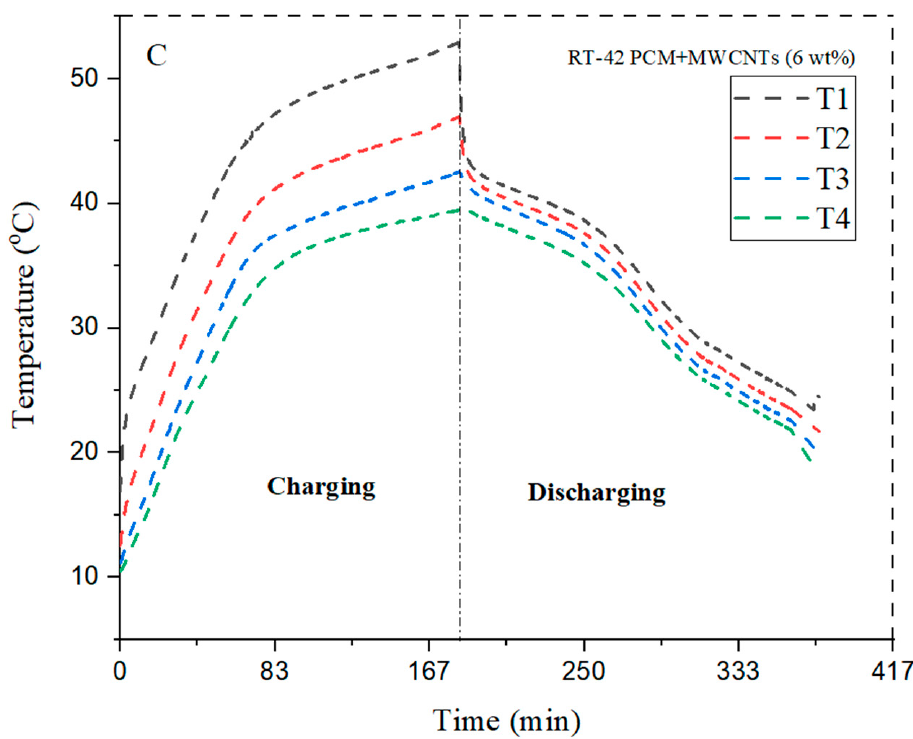
Figure 10. Comparison of different configurations with 6 wt% in a ( A ) circular, ( B ) square, and ( C ) triangular fins.